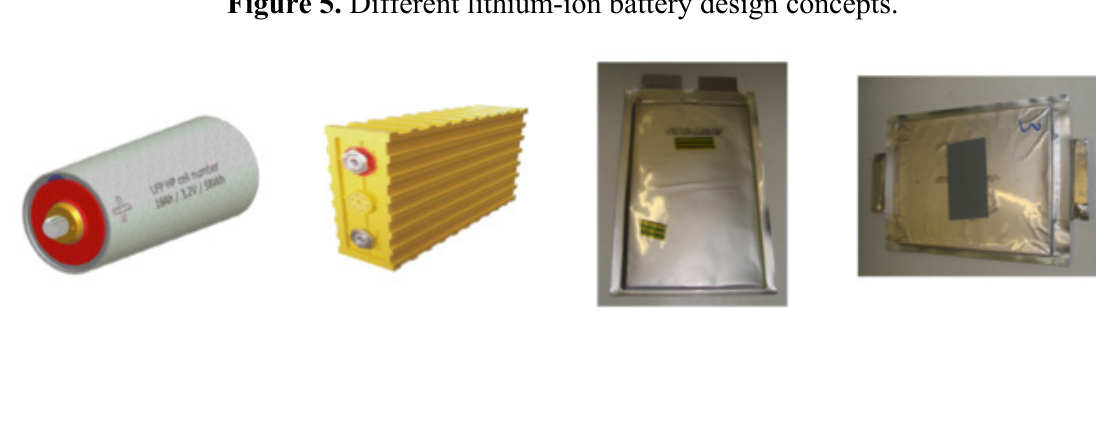
Figure 5. Different lithium-ion battery design